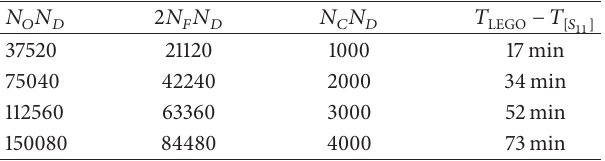
Times derived indirectly, as these simulations have not been run as such. Table 3: Computation times for the problem of Figures 8 and 9.